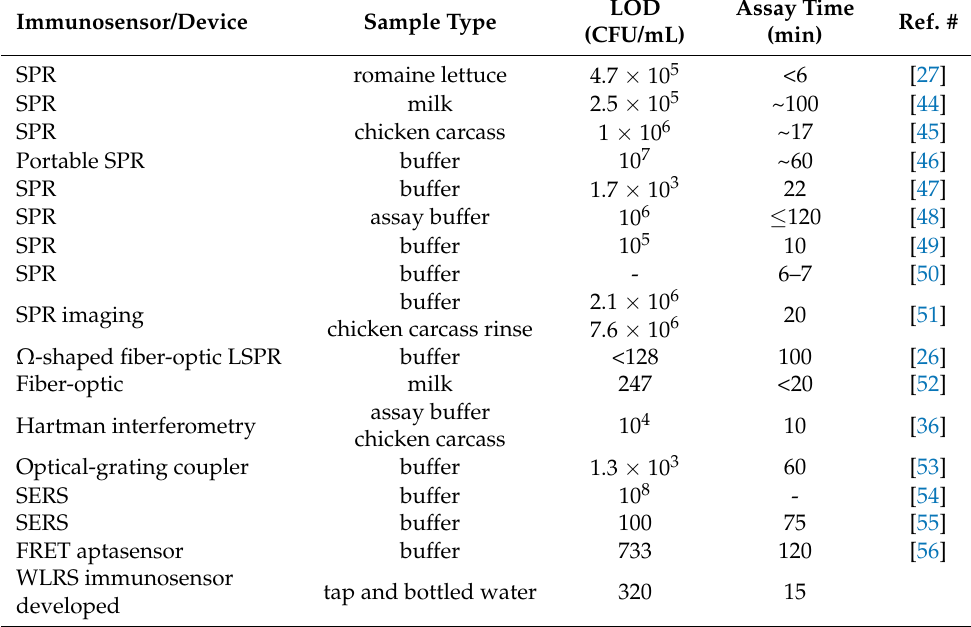
Table 2. Comparison of the developed WLRS immunosensor with other studied optical label-free immunosensors for the detection of S. typhimurium